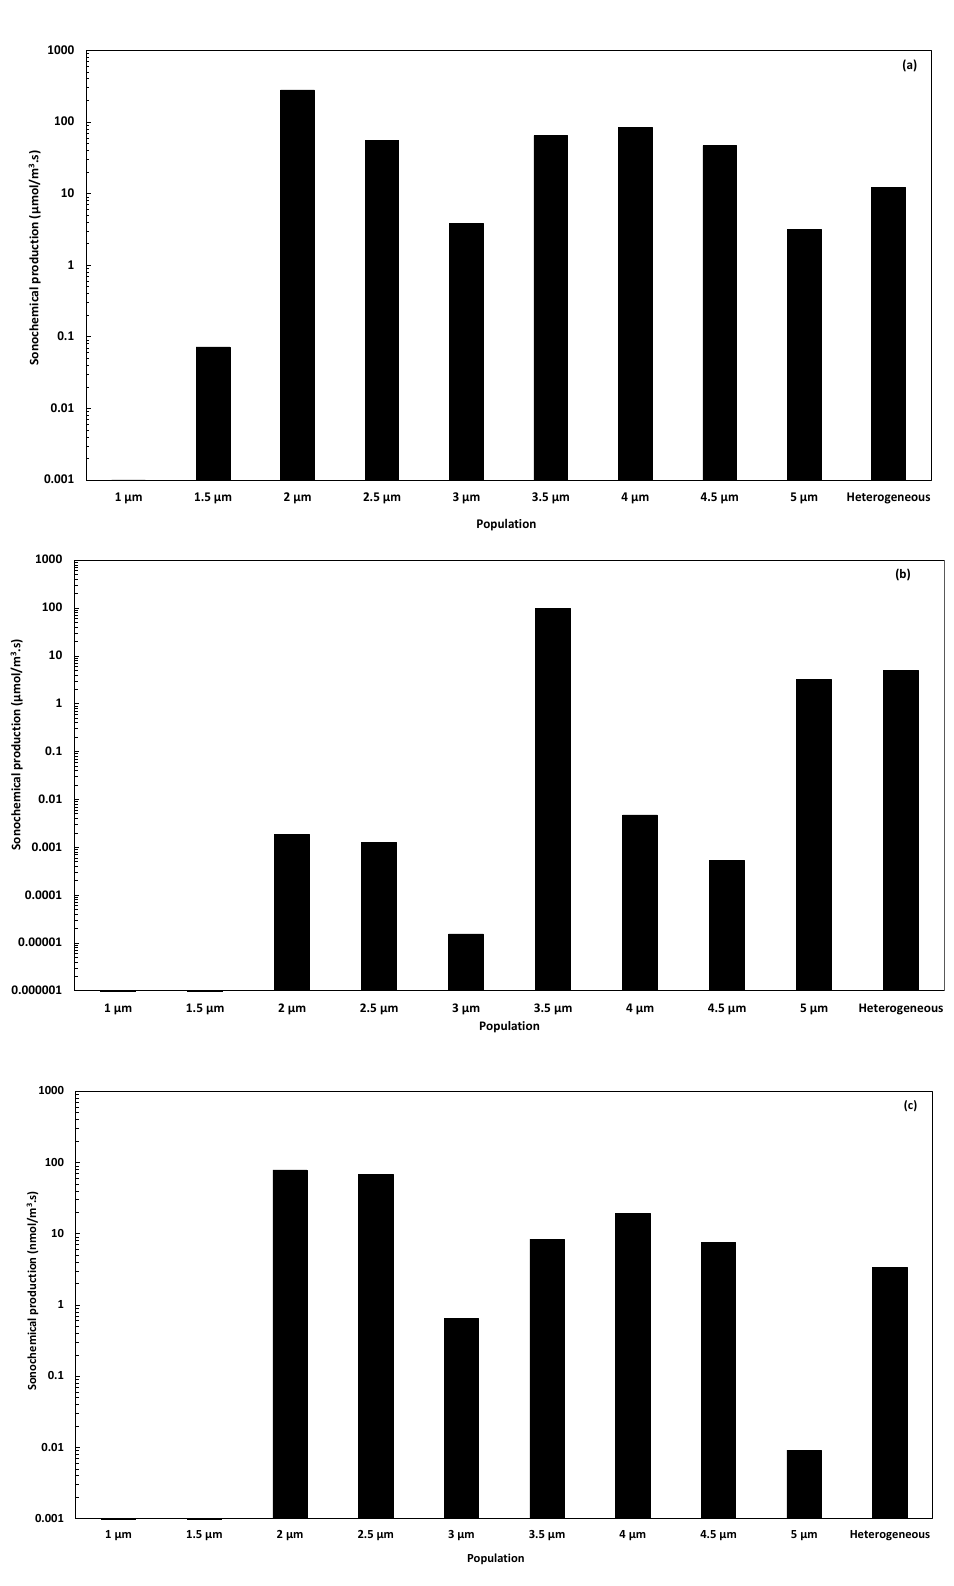
Figure 8. Sonochemical production rates of HO • ( a ), HO 2 • ( b ), and H • ( c ) per unit volume of liquid within homogeneous populations of different equilibrium radii and a heterogeneous population.